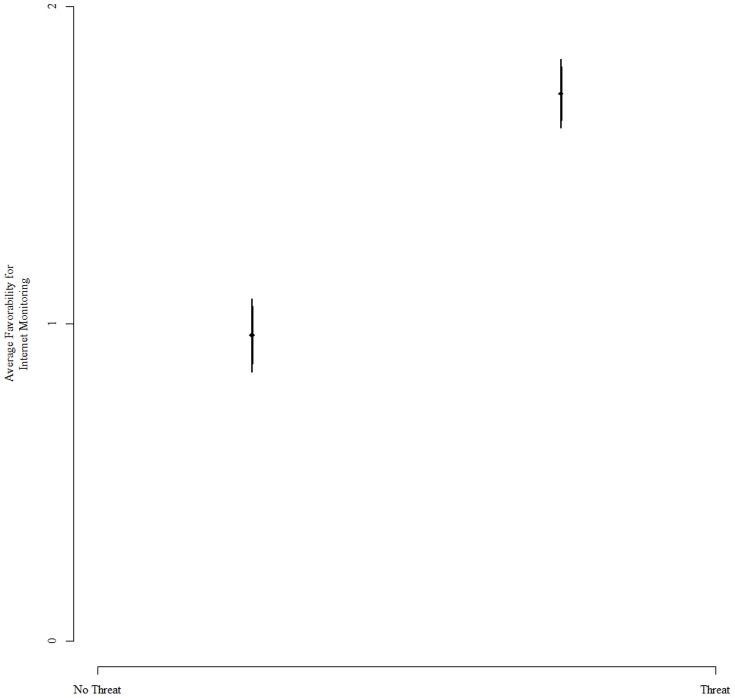
This figure displays the effect of the threat treatment on an individual's support for governmental monitoring of the internet (larger values imply greater support).The figure indicates that the treatment significantly increases support for these policies (p<.001). This result coincides with my theoretical expectations, indicating that mentioning threats makes policies purported to reduce threats more attractive.